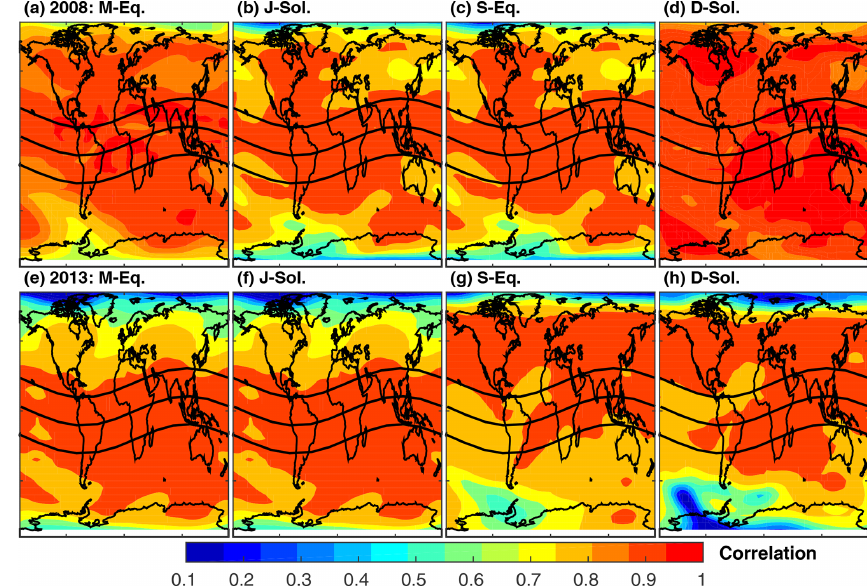
Figure 9. Correlation between IRI-2016 and IGS GPS-TEC for the four seasons during 2008 (a–d) and 2013 (e–h) .